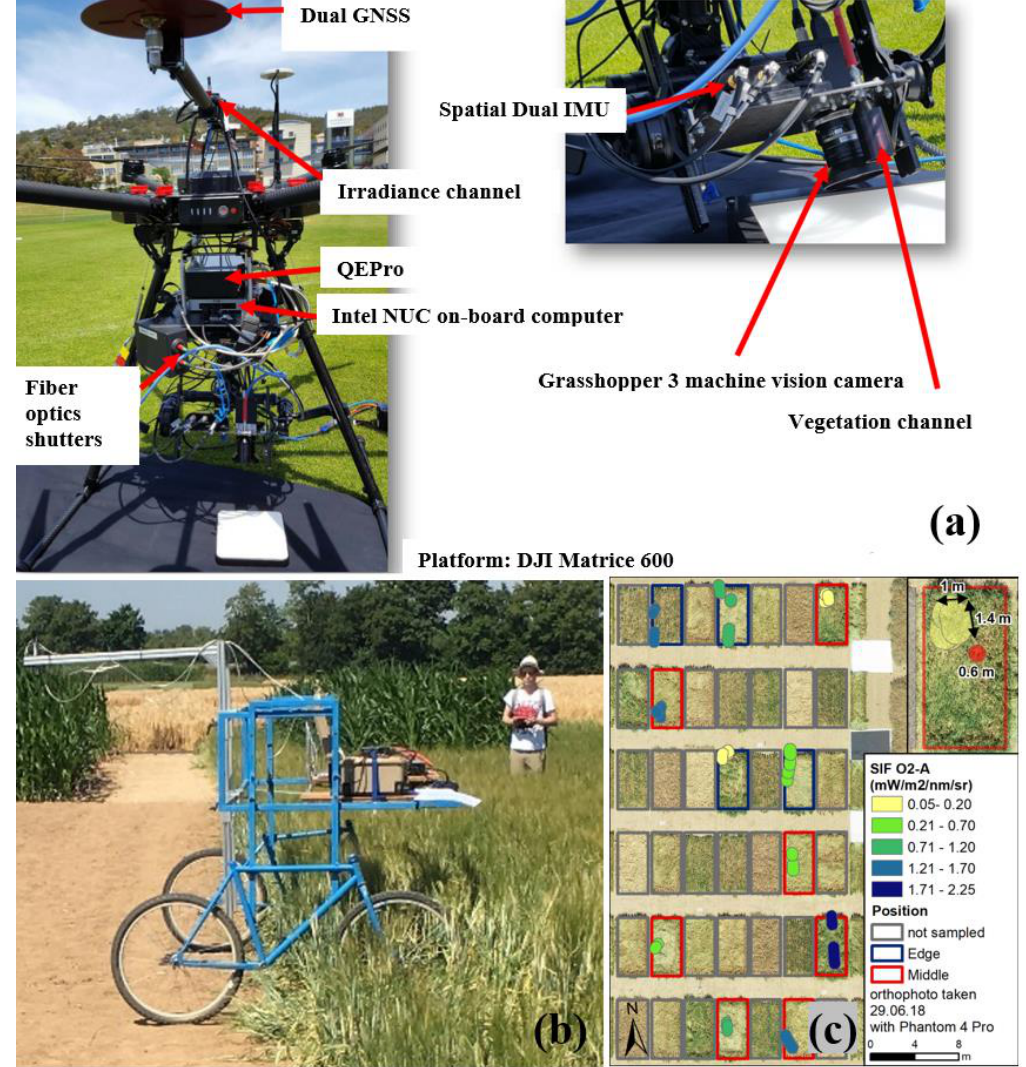
Figure 4. ( a ) AirSIF system components, ( b ) field bike used for ground Flox measurements, and ( c ) footprints of the flight at 12:00 local time with their respective O 2 -A SIF at edge (blue) and middle (red) sampled plots over the orthophoto derived from UAS photogrammetry [49].